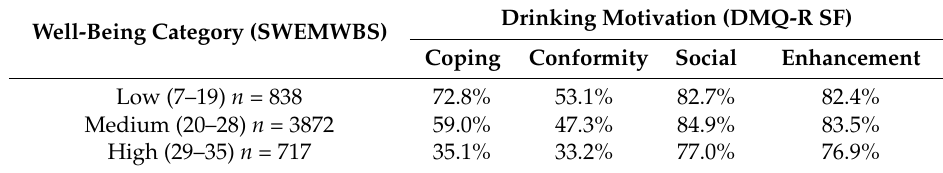
Table 4. Proportion of drinkers in each well-being category that drink for each drinking